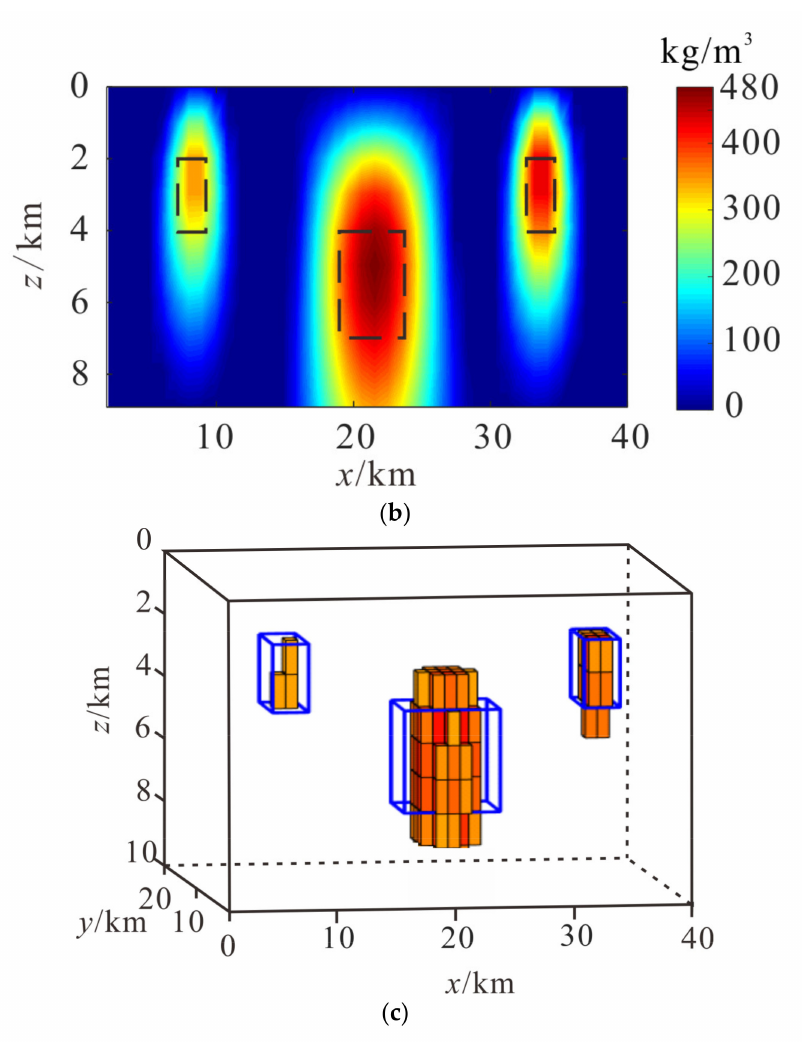
Figure 11. Complex model tests using airborne gravity and calculated vertical gradient data. ( a ) Cal- culated airborne gravity gradient data. ( b ) Density slice (y = 10 km) by cooperate density-integrated inversion method. ( c ) 3D density distribution (larger than 370 kg/m 3 ) by cooperate density-integrated inversion